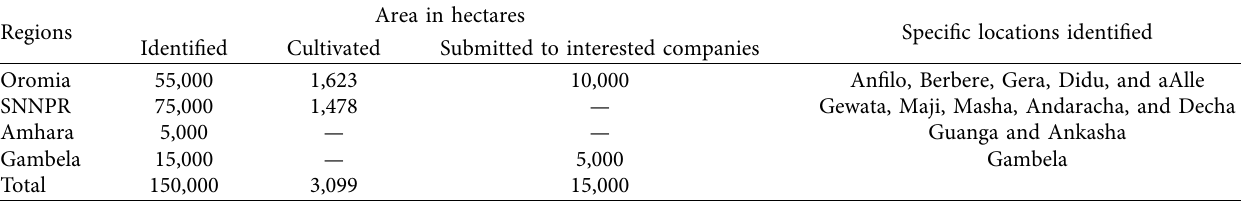
Table 1: Estimated tea production potential of Ethiopia by region, area, and specific